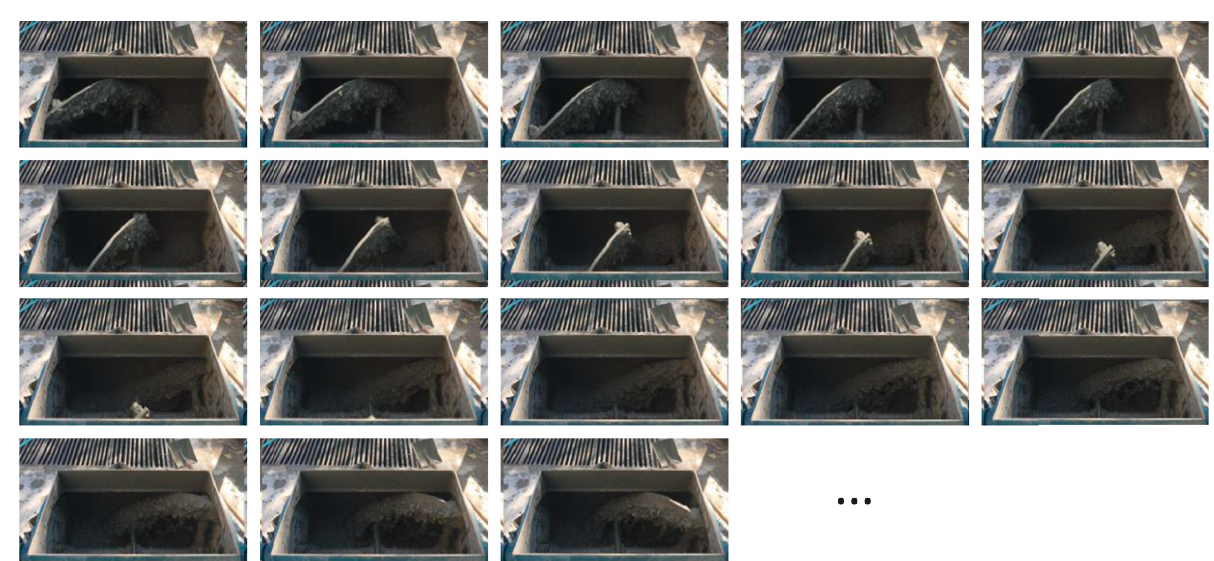
Figure 3: The frames extracted from